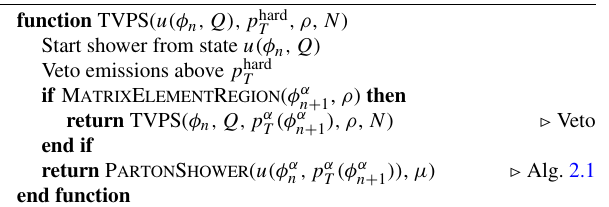
Algorithm 2.3 Transparent Vetoed Parton